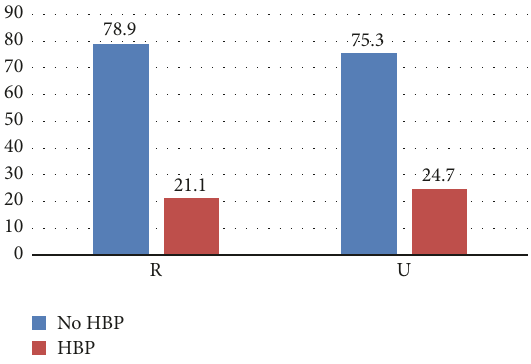
Figure 1: Blood pressure profile in rural and urban